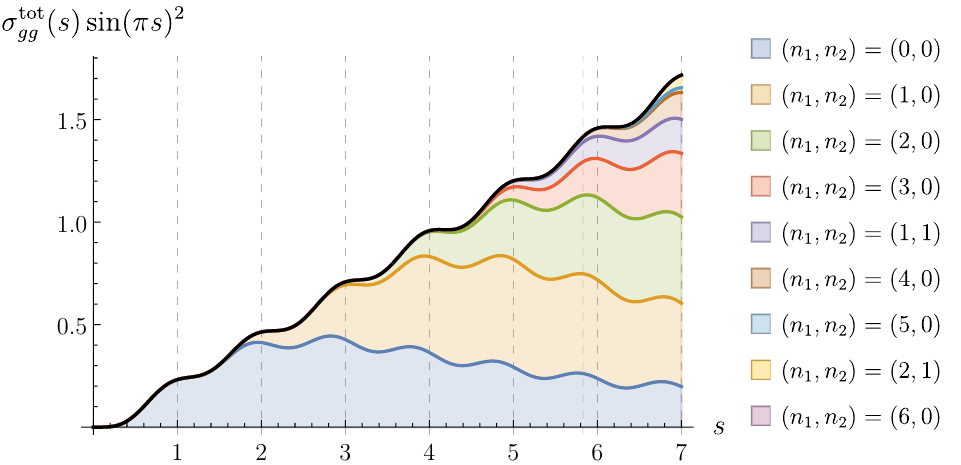
Figure 27: Total cross section of the planar annulus amplitude, proportional to s Im A p , normalized by sin ( π s ) 2 in order to remove double poles (black). We set the an polarization and color dependence to 1. Contributions from the individual thresholds are denoted with